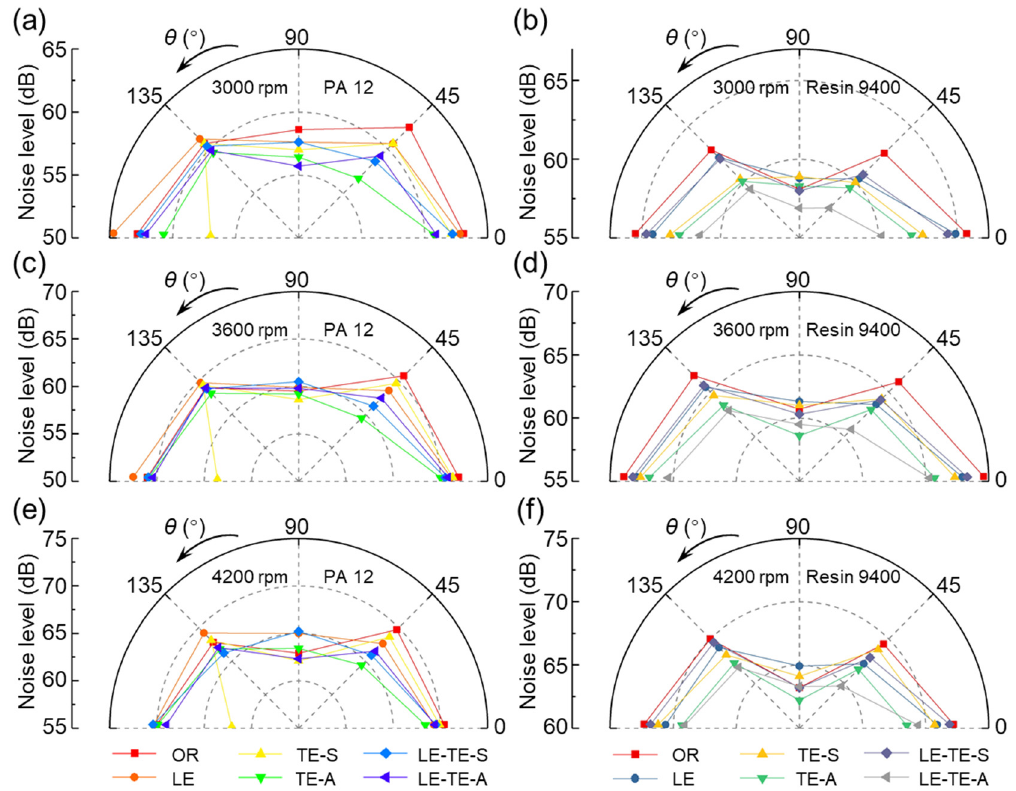
Figure 13. Noise directivity distribution of different rotors at 3000–4200 rpm. ( a , c , e ) Rotors with PA 12 at 3000 rpm, 3600 rpm, and 4200 rpm. ( b , d , f ) Rotors with Resin 9400 at 3000 rpm, 3600 rpm, and 4200 rpm.